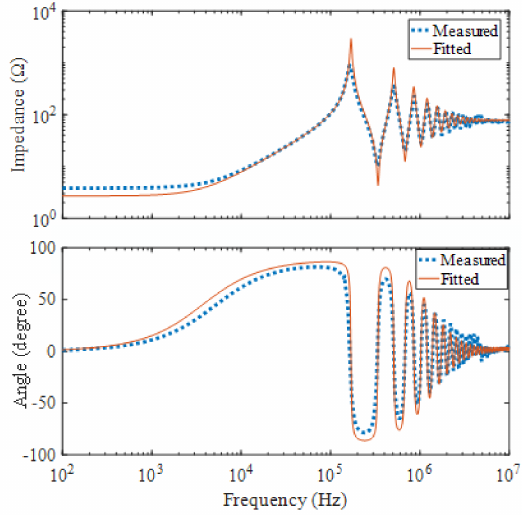
Figure 6. SC impedance of 200 m power cable in DM.